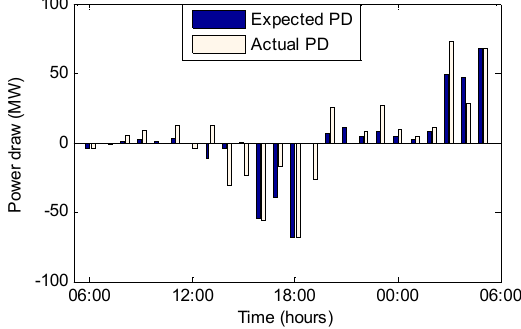
Figure 11. Expected and actual power draw of all EVs.